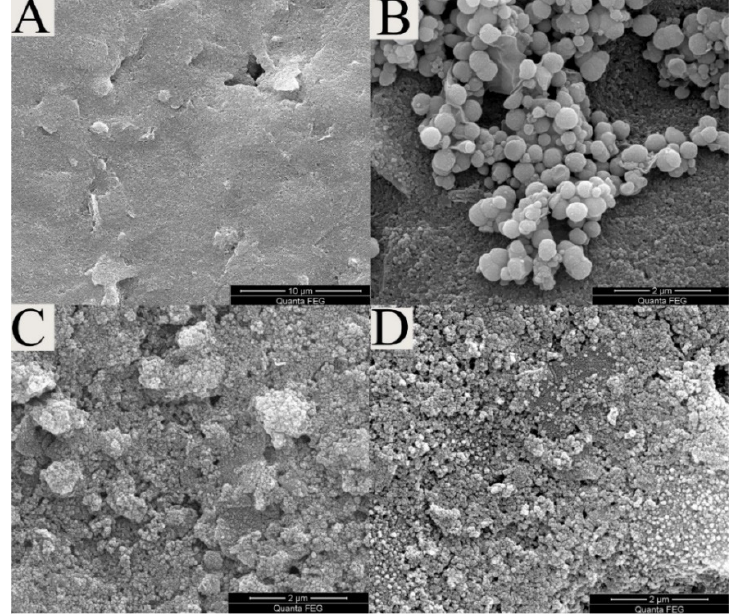
Figure 4. SEM images of ( A ) bare SPE, ( B ) GO/Fe 3 O 4 nanocomposites, ( C ) GO/Fe 3 O 4 /PB nanocomposites, and ( D ) GO/Fe 3 O 4 /PB@AuNPs nanocomposites.